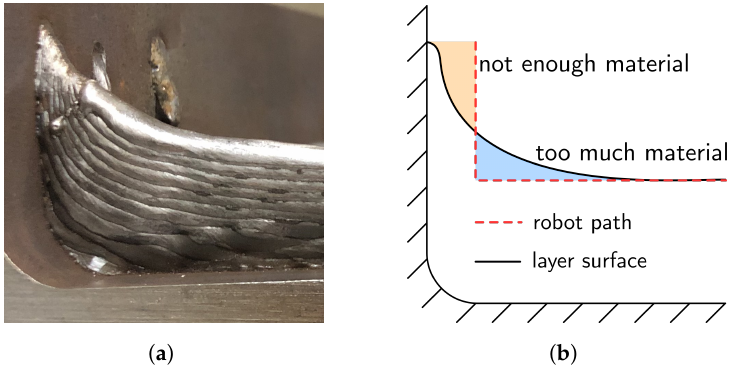
Figure 18. Deviation between robot path and real layer ( a ) built volume ( b ) schematic